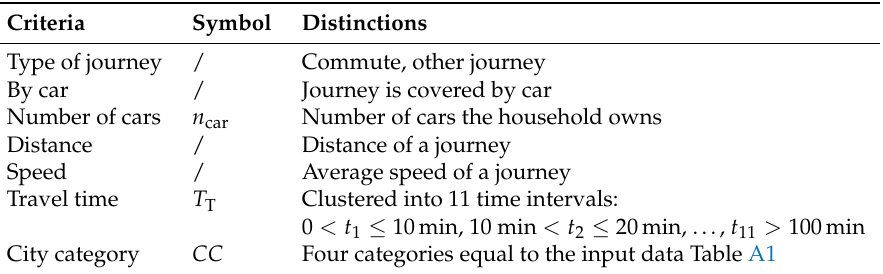
Table 6. Criteria to filter the MiD data.